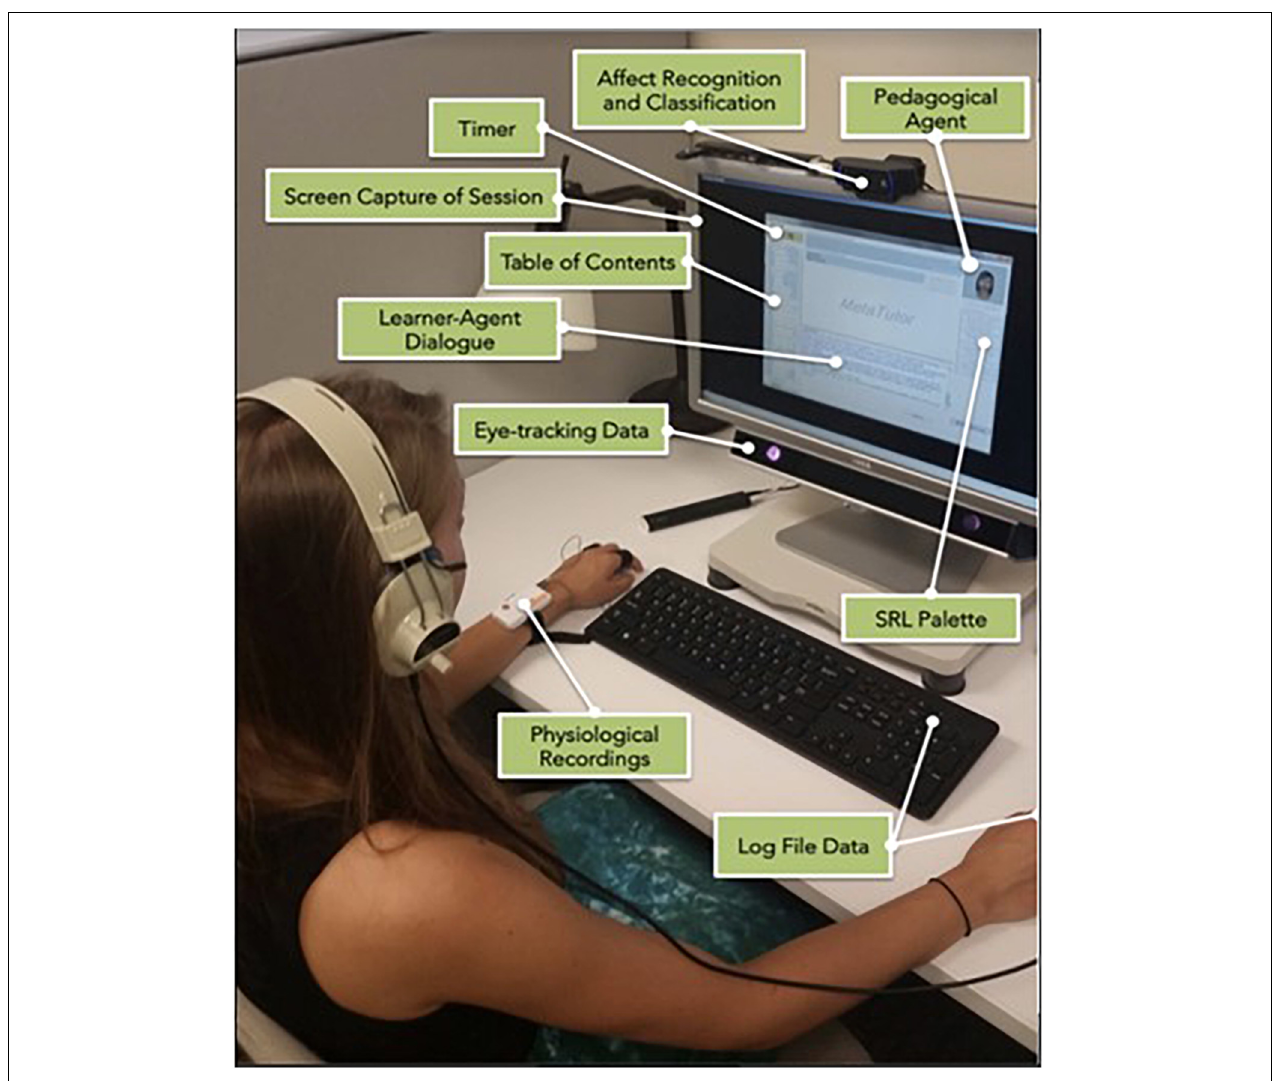
FIGURE 2 | Instrumented student participating in a typical MetaTutor